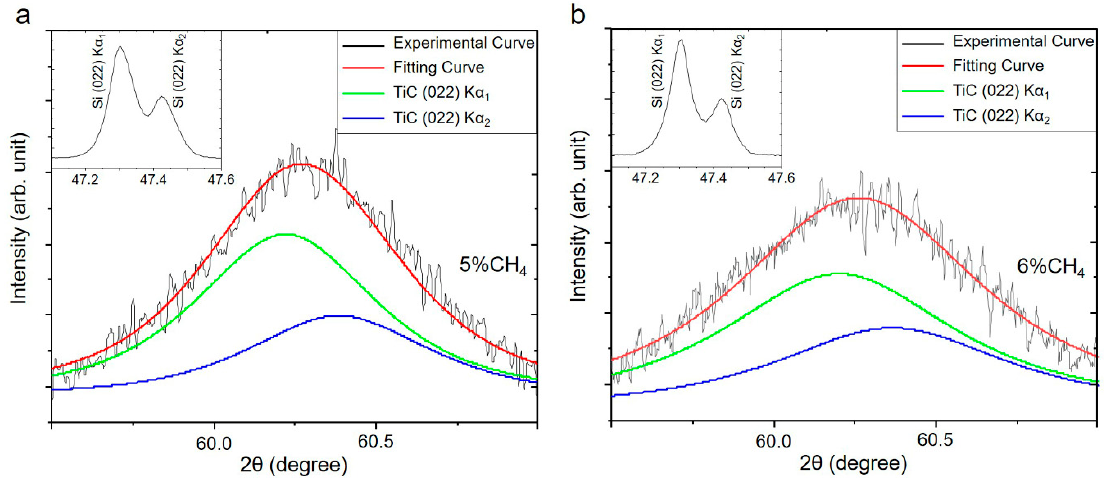
Figure 4. In-plane XRD 2 θ - ω patterns of TiC 022 reflection with inset showing the corresponding pattern of Si 022 reflection. ( a ) 5% CH 4 and ( b ) 6% CH 4 . Curve fitting showing the peaks of TiC from Cu K α 1 and K α 2 X-rays in a 2 / 1 ratio for the corresponding integrated intensity.